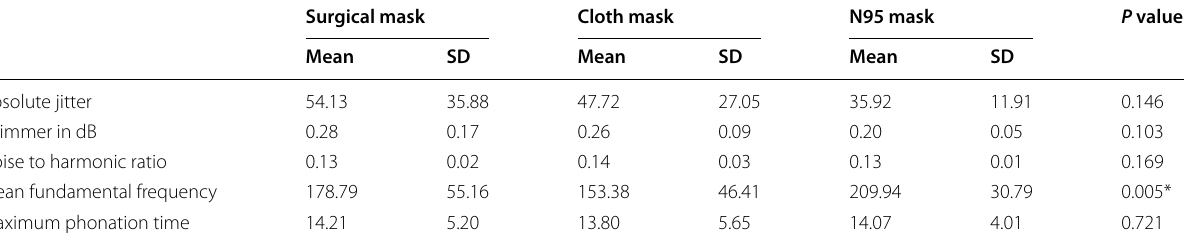
* Significant p value < 0.05, SD standard deviation, dB